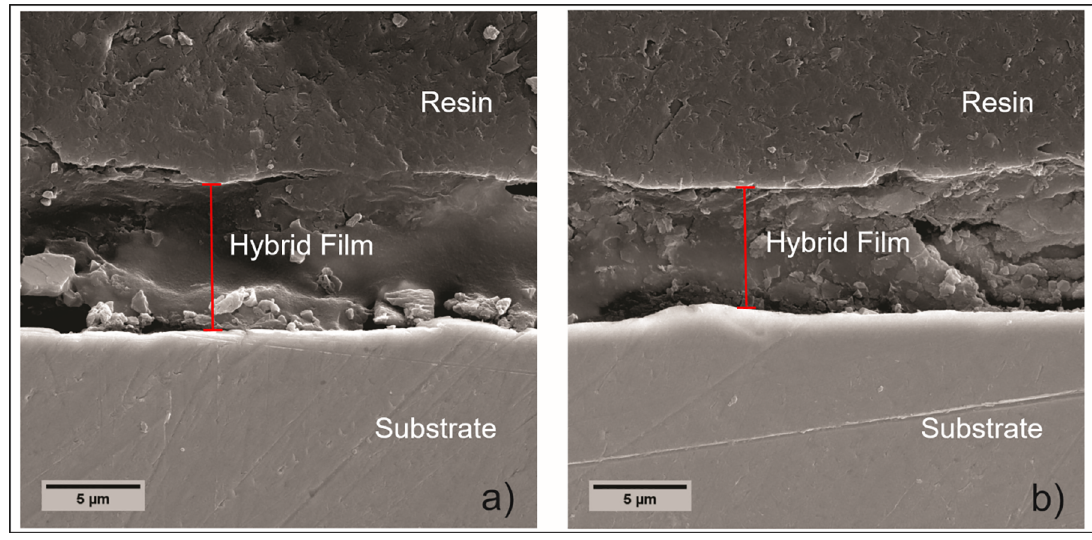
Figure 4. FEG-SEM image of the transversal section of the studied samples: (a) 316L_1 and (b) 316L_2.